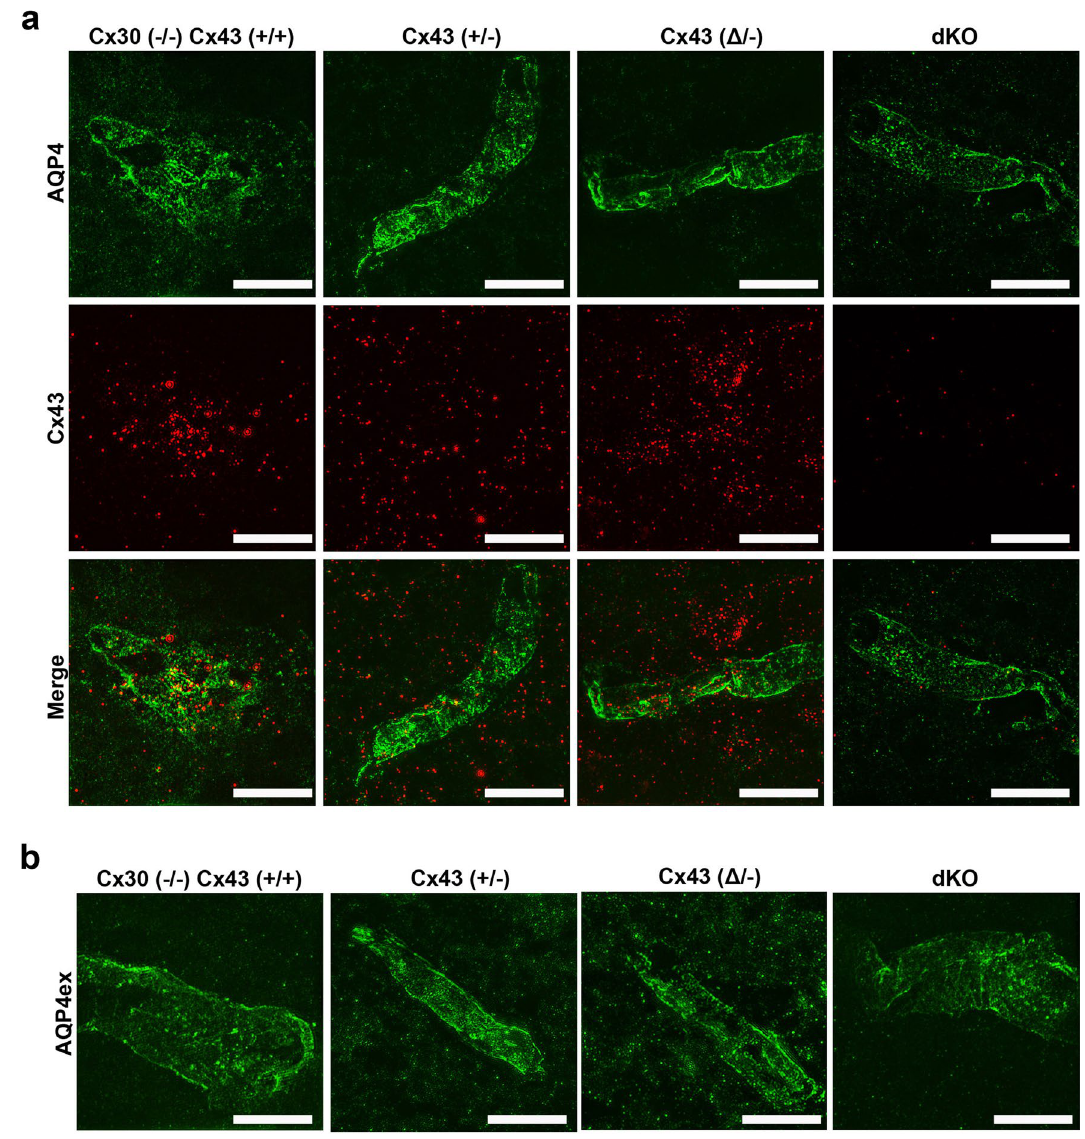
Figure 3. Distribution of Cx43, AQP4 and AQP4ex in brain sections from Cx43 transgenic mice. ( a ) 3D SIM reconstruction showing the expression of Cx43 (red) and AQP4 (green) in Cx43 (+/+) /Cx30 (−/−) , Cx43 (+/−) , Cx43 (Δ/−) , and dKO brain sections. ( b ) 3D SIM images showing the expression of AQP4ex (green) in brain sections from each genotype. Scale bars 10